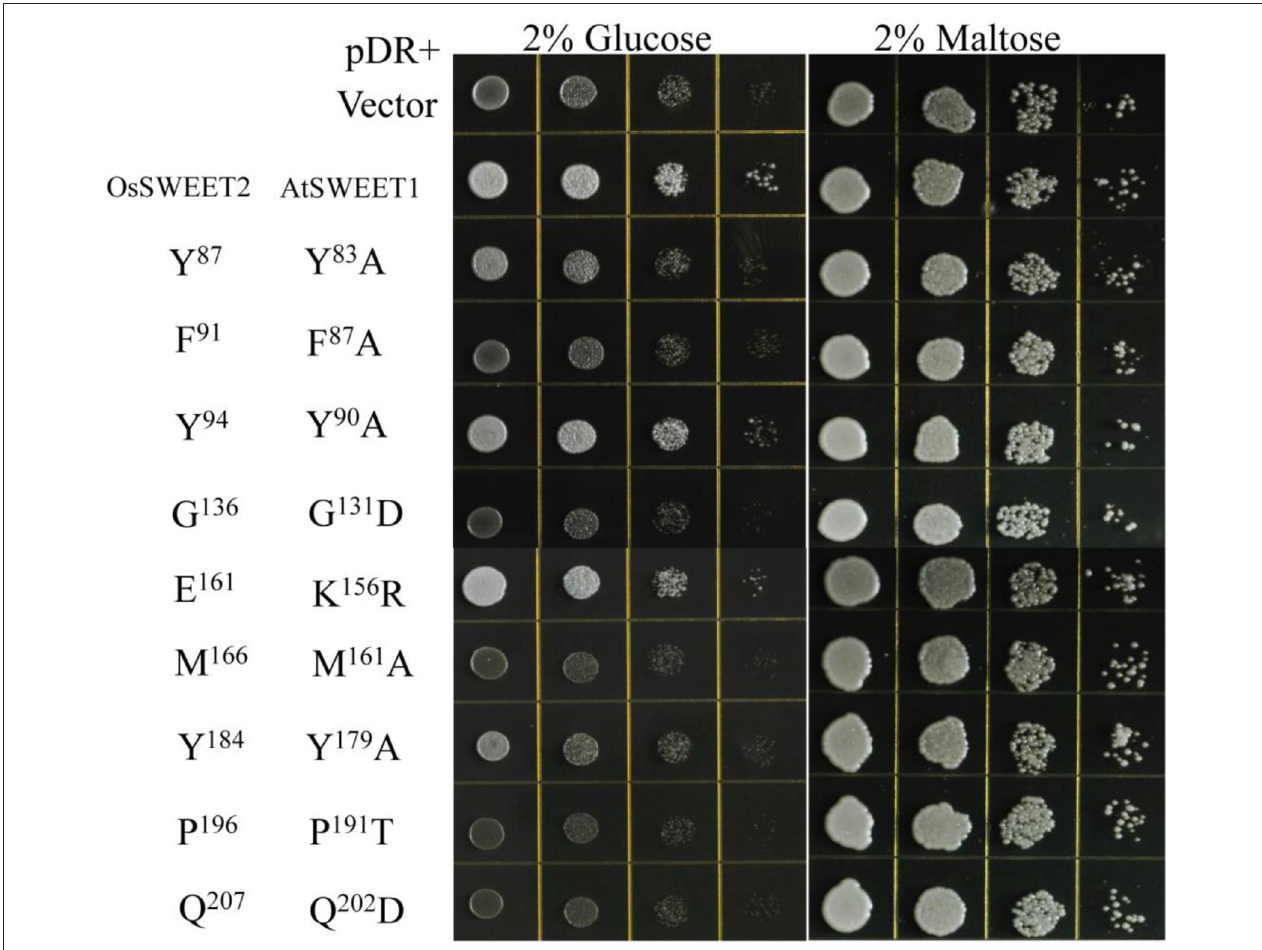
FIGURE 10 | Growth assays of AtSWEET1 mutants expressed in yeast strain EBY4000 were performed on YNB medium containing 2% glucose or maltose. Except for AtSWEET1 mutants Y 83 A, Y 90 A, Y 179 A, and K 156 R, other mutations (F 87 A, G 131 D, M 161 A, P 191 T, and Q 202 D) in AtSWEET1 led to loss of glucose transport activity. Empty vector (pDRf1) and AtSWEET1 were used as the negative and positive controls, respectively. 10 6 yeast cells were spotted in the starting points and further grown at 28 ◦ C for 3 days. The corresponding conserved residues in OsSWEET2 are shown next to the residues from